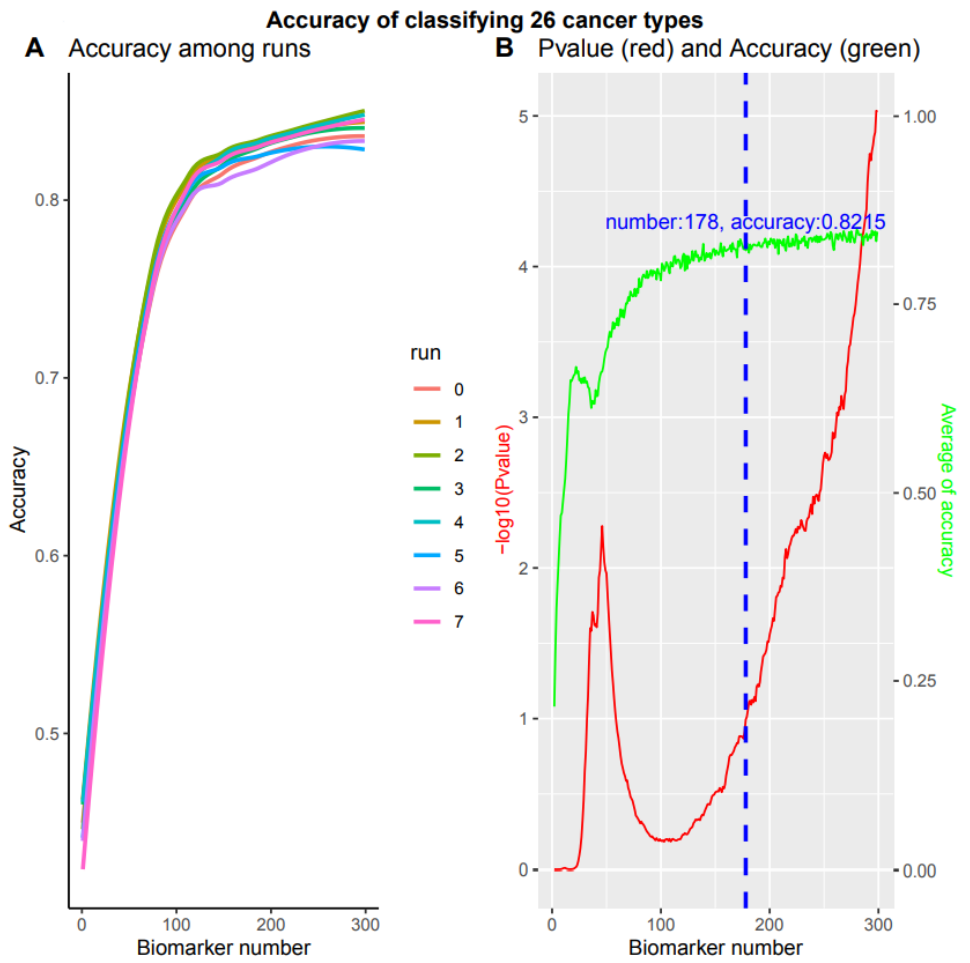
Figure 6. Multiple classifications of total 26 cancer types. Overall accuracy of 8 independent runs with accumulated 300 biomarkers respectively. ( A ) Accuracy for 8 independent runs. ( B ) The p value and average accuracy of 8 independent runs. The p value was calculated by Kruskal–Wallis rank sum test of 8 independent runs. Blue dashed line denotes a cutoff of -log10 ( p value) = 1, with 178 biomarkers and 82.15% accuracy.